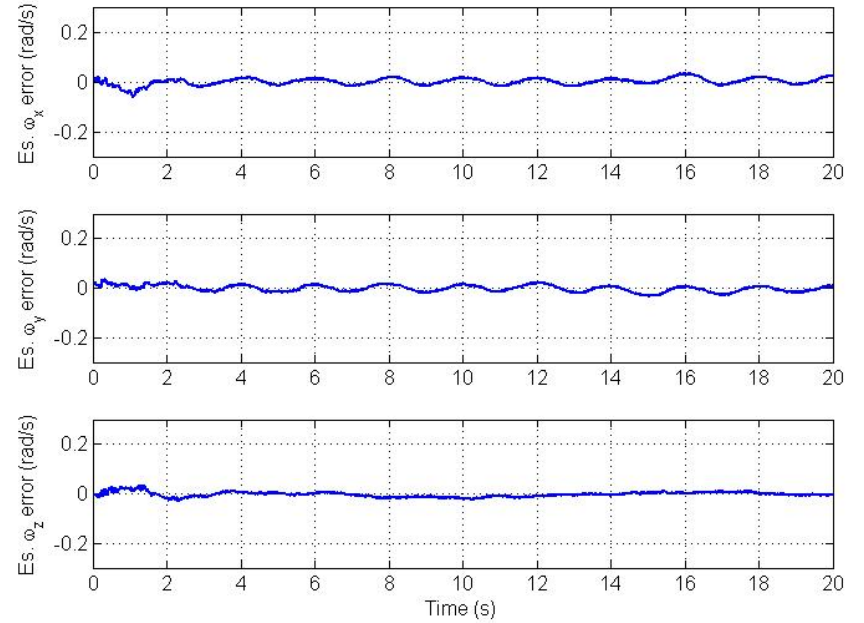
Figure 4. Angular velocity vector estimation